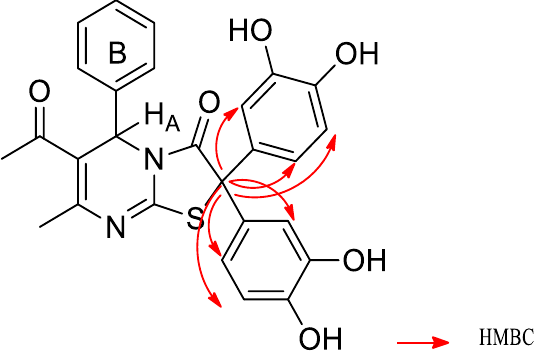
Figure 4. Correlation between quaternary carbon and protons in the catechol rings of